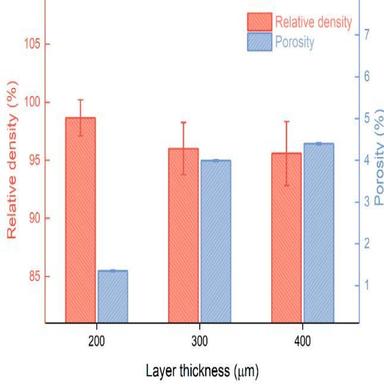
Relative density and porosity of the 3D printed zirconia specimens at different layer thickness.